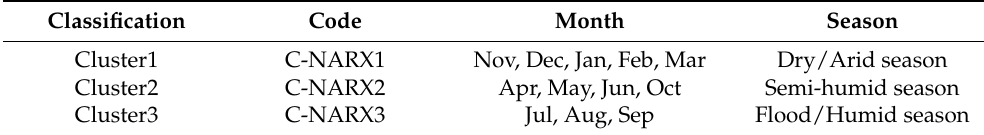
Table 2. The runoff classification based on cluster